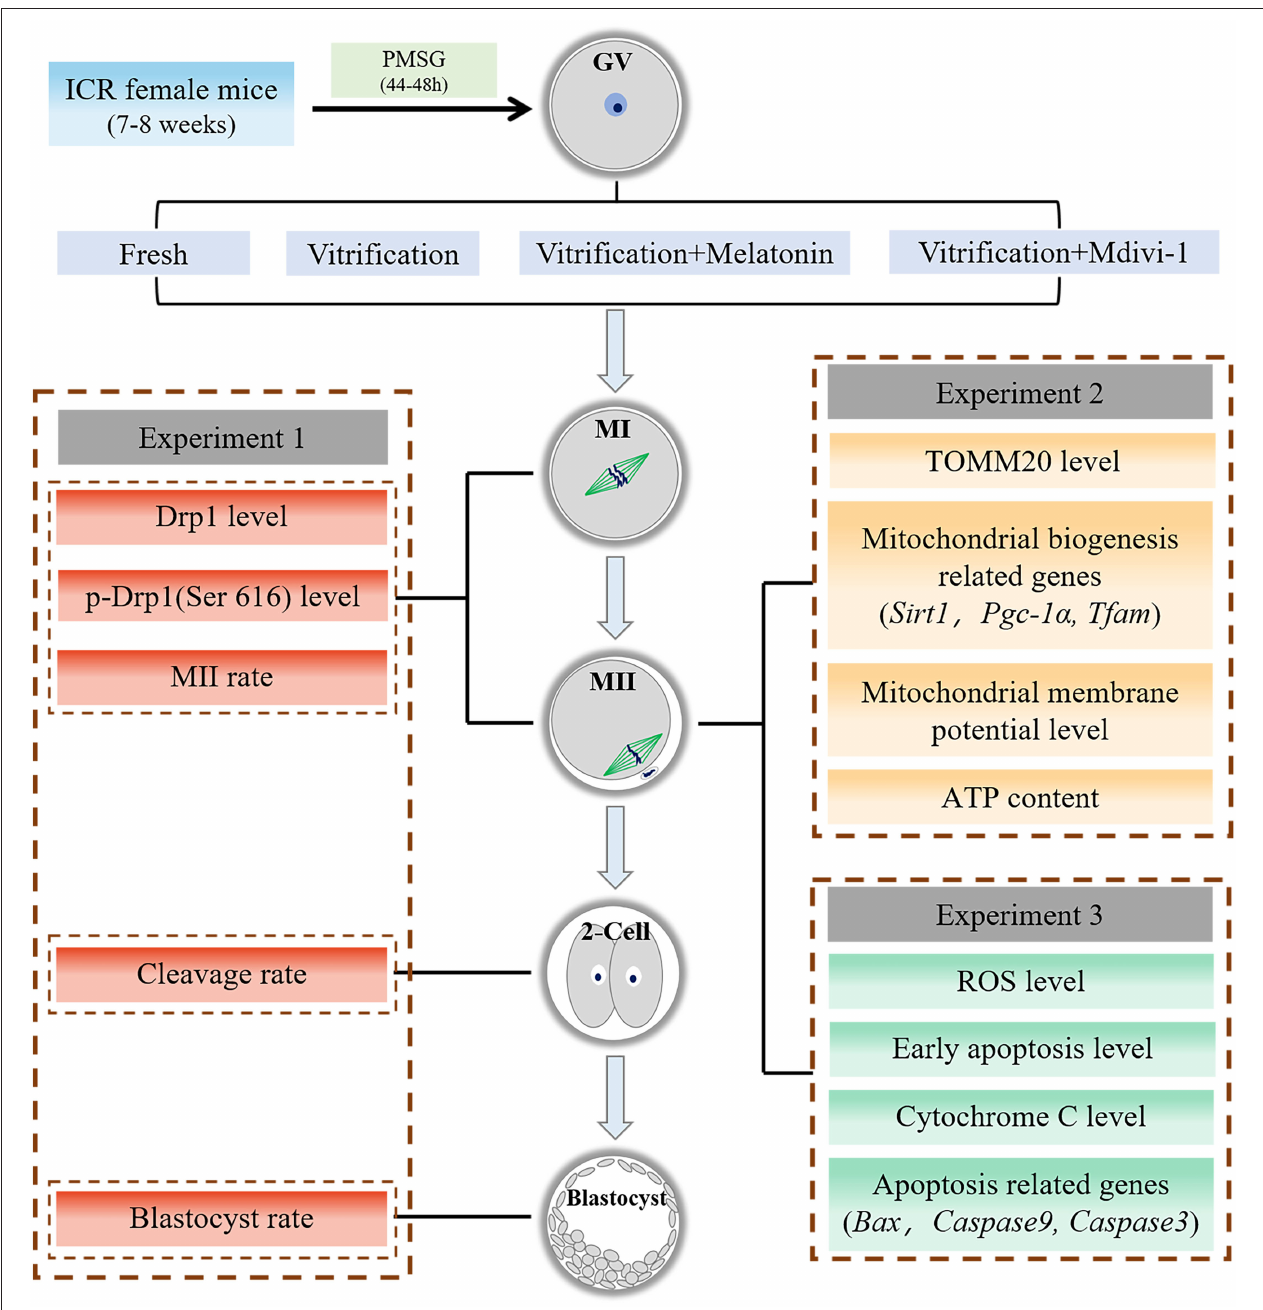
FIGURE 1 | Experiment flow chart. GV, germinal vesicle; MI, metaphase I; MII, metaphase II. Melatonin and Mdivi-1 were added to warming and maturation solutions.